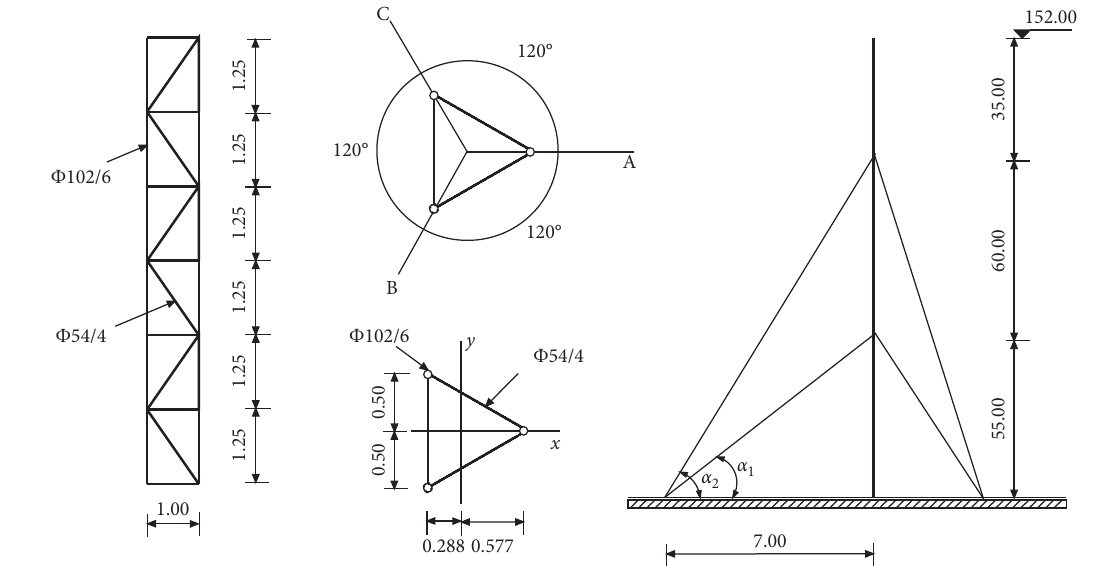
Figure 1: Schematic diagram of the guyed mast structure.